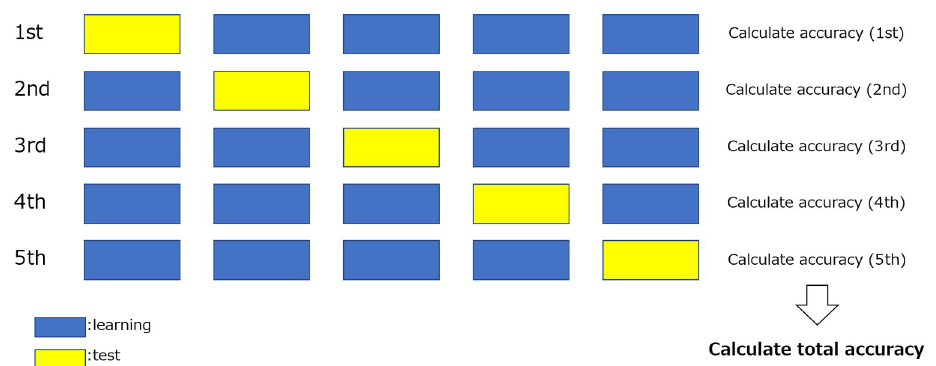
Fig 10. Simplified diagram of the cross-validation method (number of folds = 5).